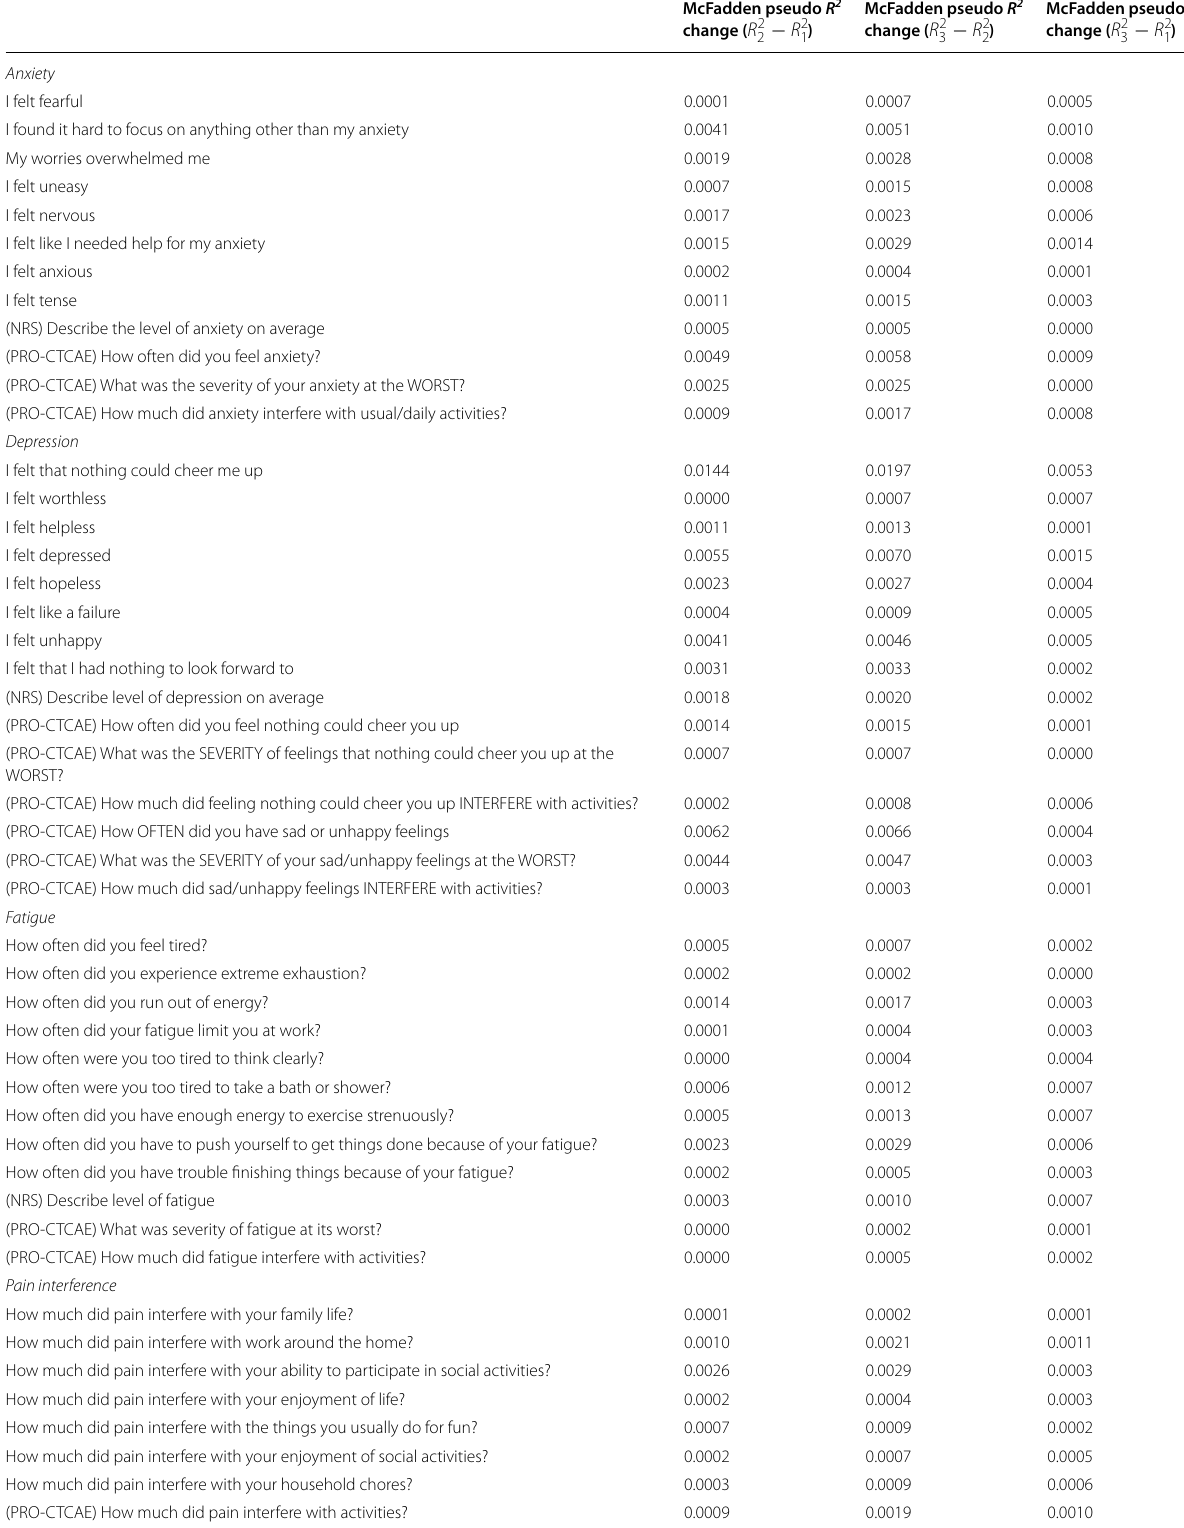
Table 6 Differential item functioning by modes of